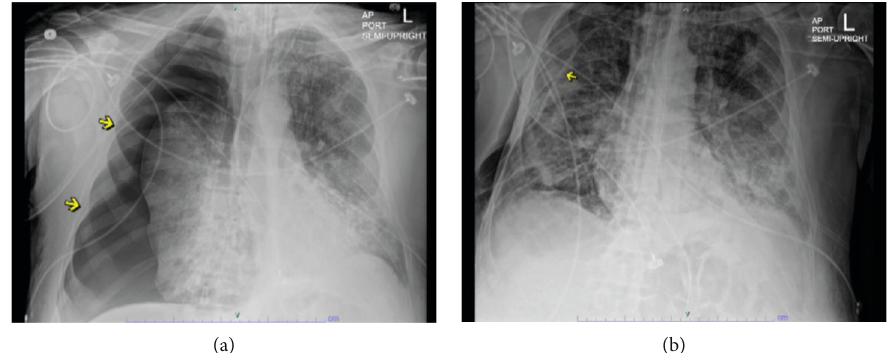
Figure 2: (a) CXR showing a large right-sided pneumothorax. (b) CXR showing resolution of the pneumothorax post chest tube